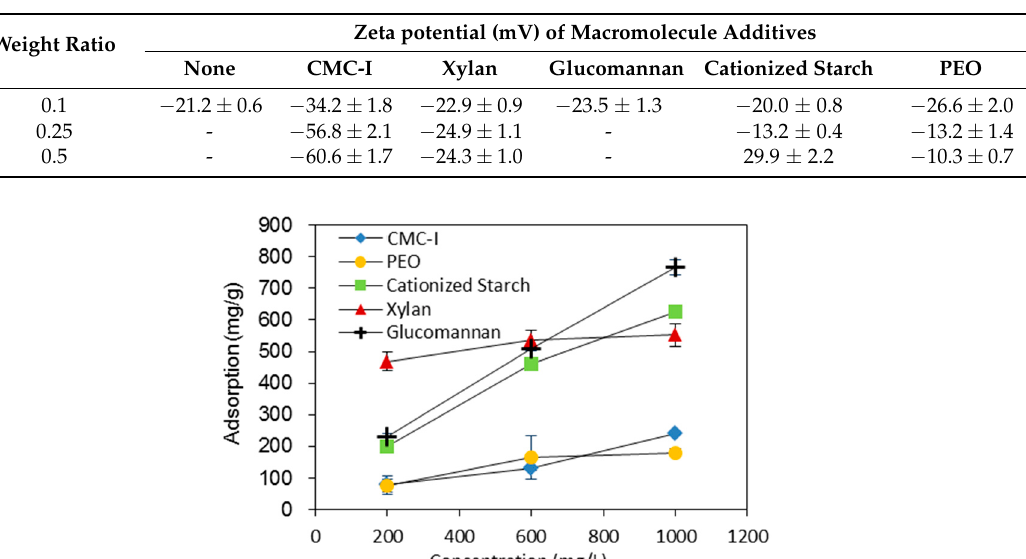
Zeta potential (mean ± STDEV) of BC fiber suspensions with additions of different macromolecules.